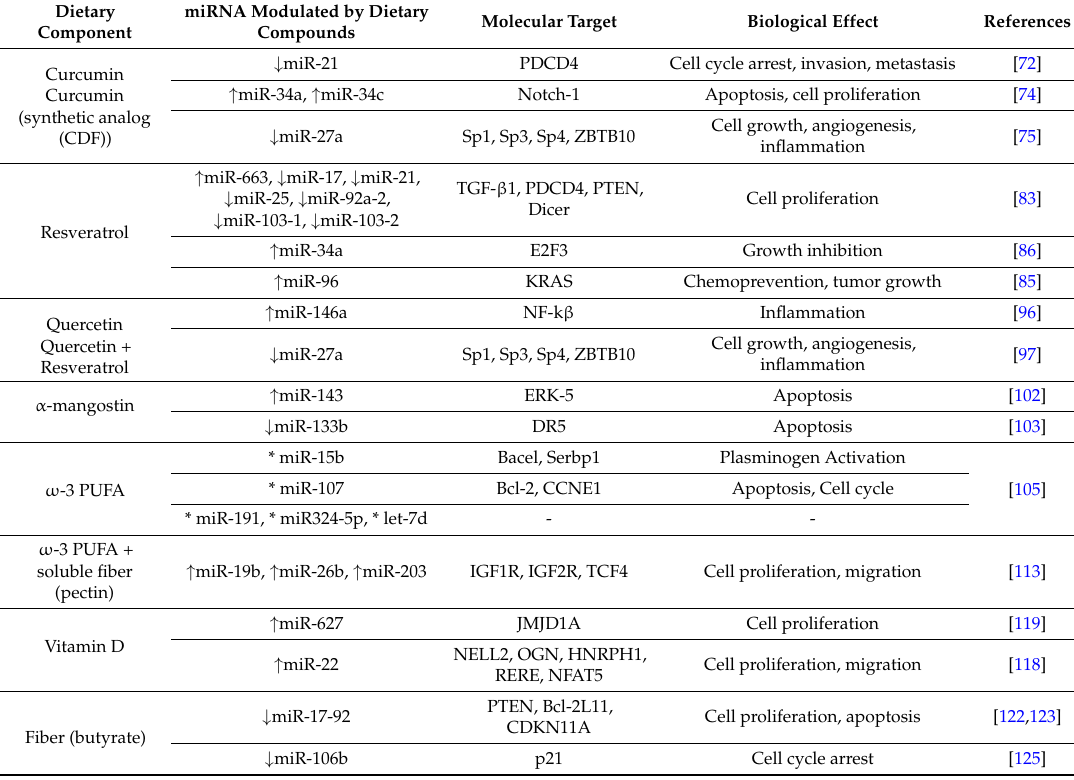
Table 1. Examples of bioactive dietary components that modulate miRNA expression: molecular targets and biological